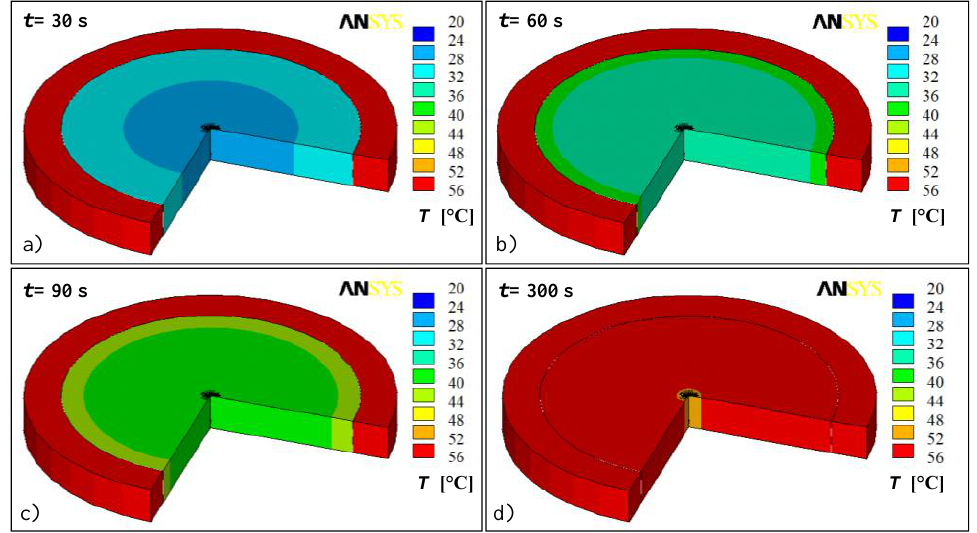
Figure 10. Temperature distribution in the probe 2 in the time of ( a ) 30 s, ( b ) 60 s, ( c ) 90 s, and ( d ) 300 s after immersing the probe in a water bath at approximately 55 °C.